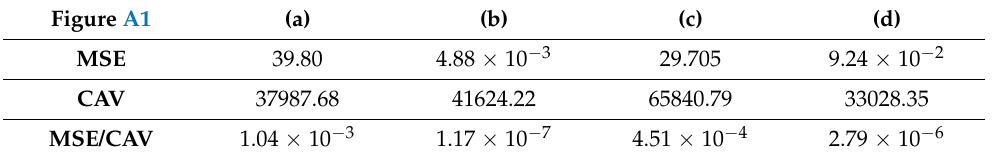
Table A1. The centralizer of the